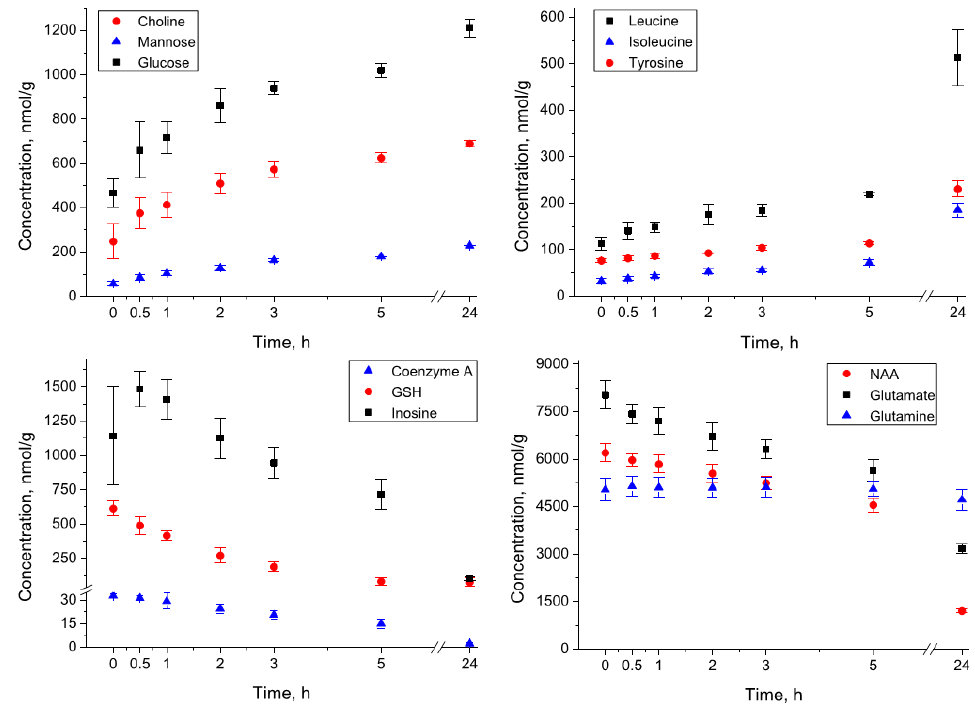
Figure 2. Kinetics of metabolite concentrations in the rat brain homogenates during the incubation at 4 °C.